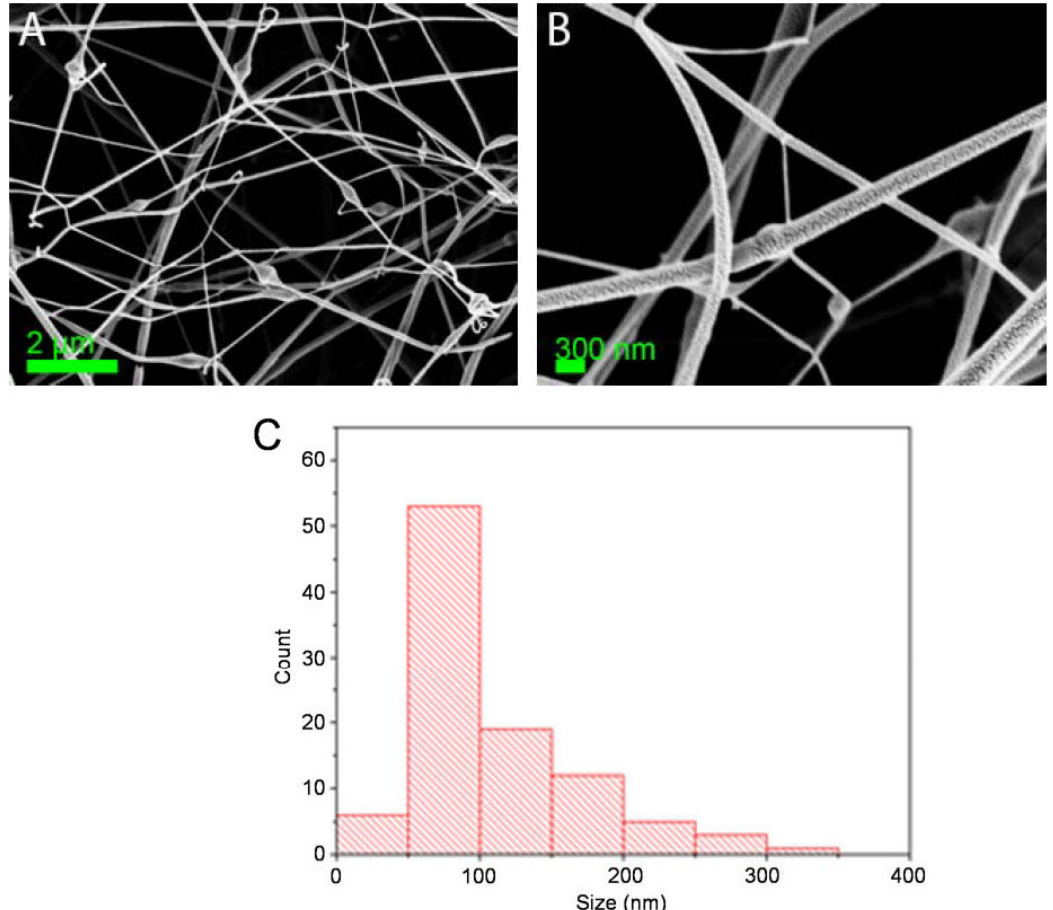
Figure 4. SEM image of Electrospun 10% by weight cellulose acetate (CA)/LTA non-porous fibers ( A ) and at higher magnification ( B ) with the measured fiber diameter distribution shown in the histogram ( C